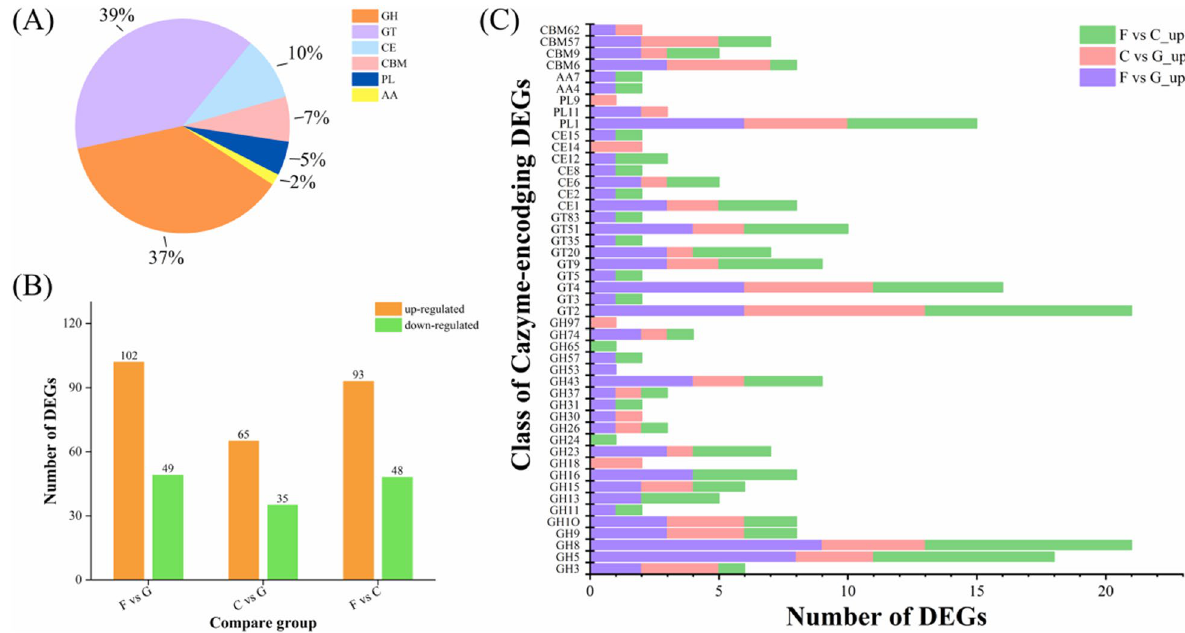
Fig. 3 Statistical analysis of DEGs encodingCAZymes. A : Family classification of all DEGs. B : Statistics of up/downregulated CAZymes in each combination. C : Detailed classification of families with upregulated CAZymes in each